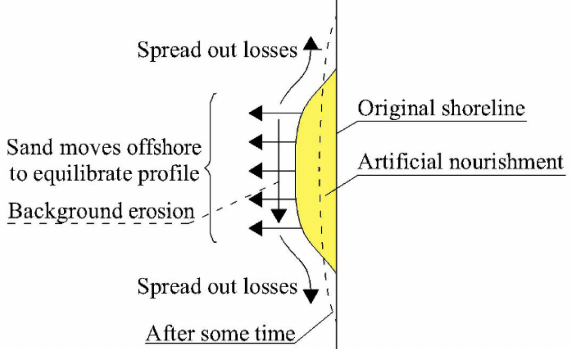
Figure 1. Artificial nourishment shoreline evolution and plan view of the erosion processes associated with the nourishment (based on